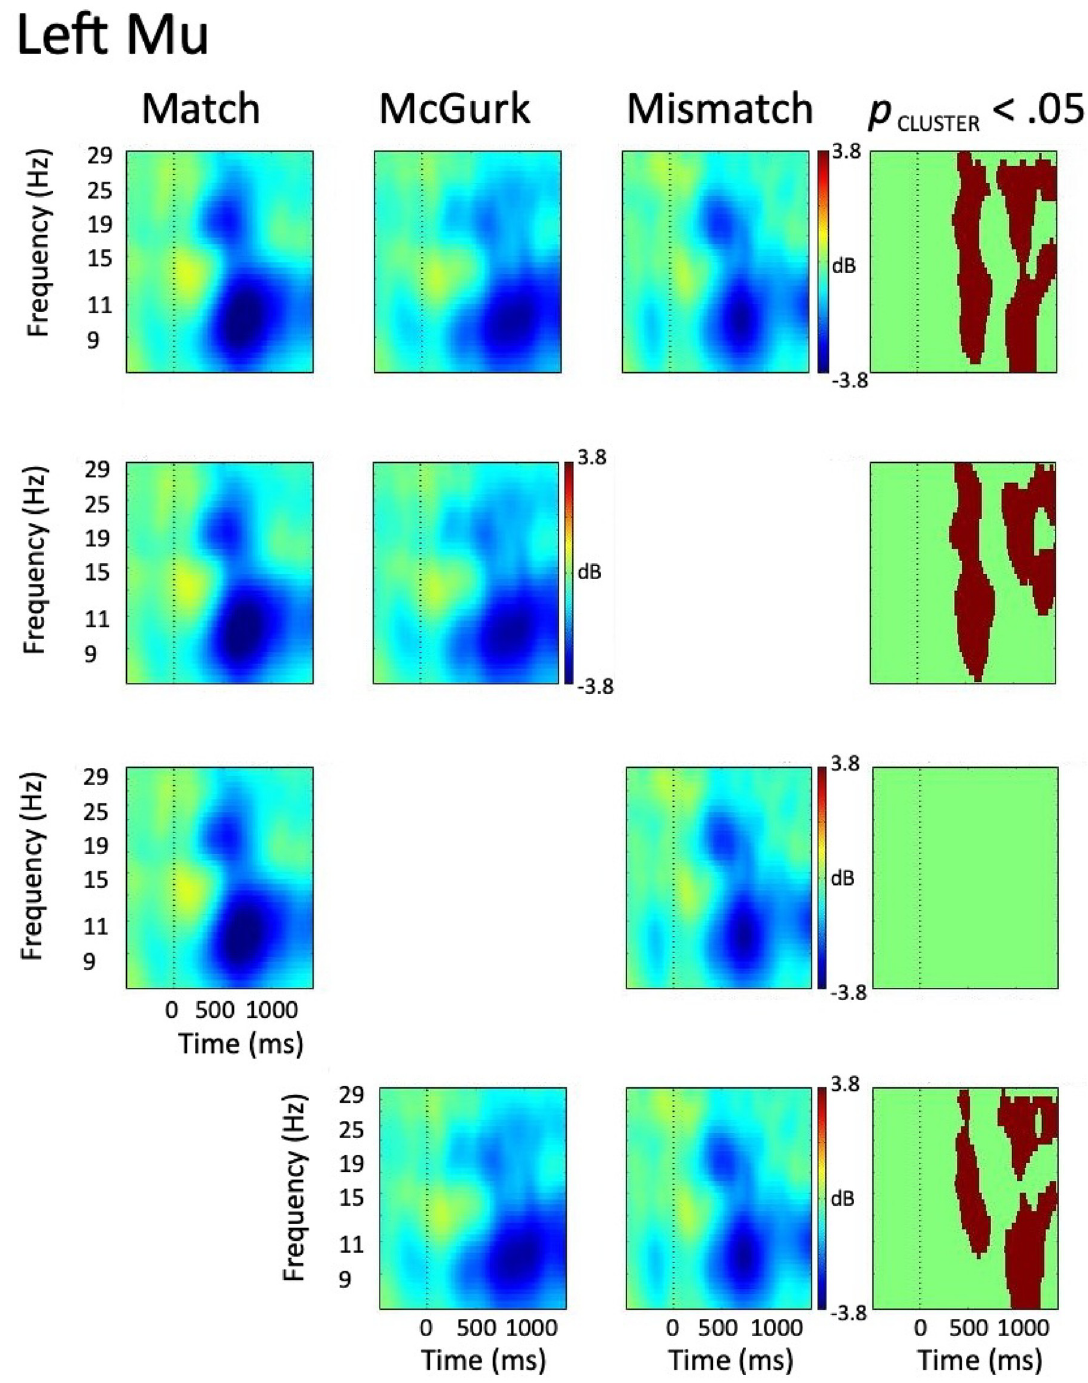
Fig 4. ERSP data from left hemisphere mu cluster. The first three columns represent data from Match, McGurk, and Mismatch conditions, with the right-most column showing time-frequency voxels significant at p < .05 (cluster corrected). The top row shows the results of the omnibus tests, while the lower rows show the results of the post-hoc